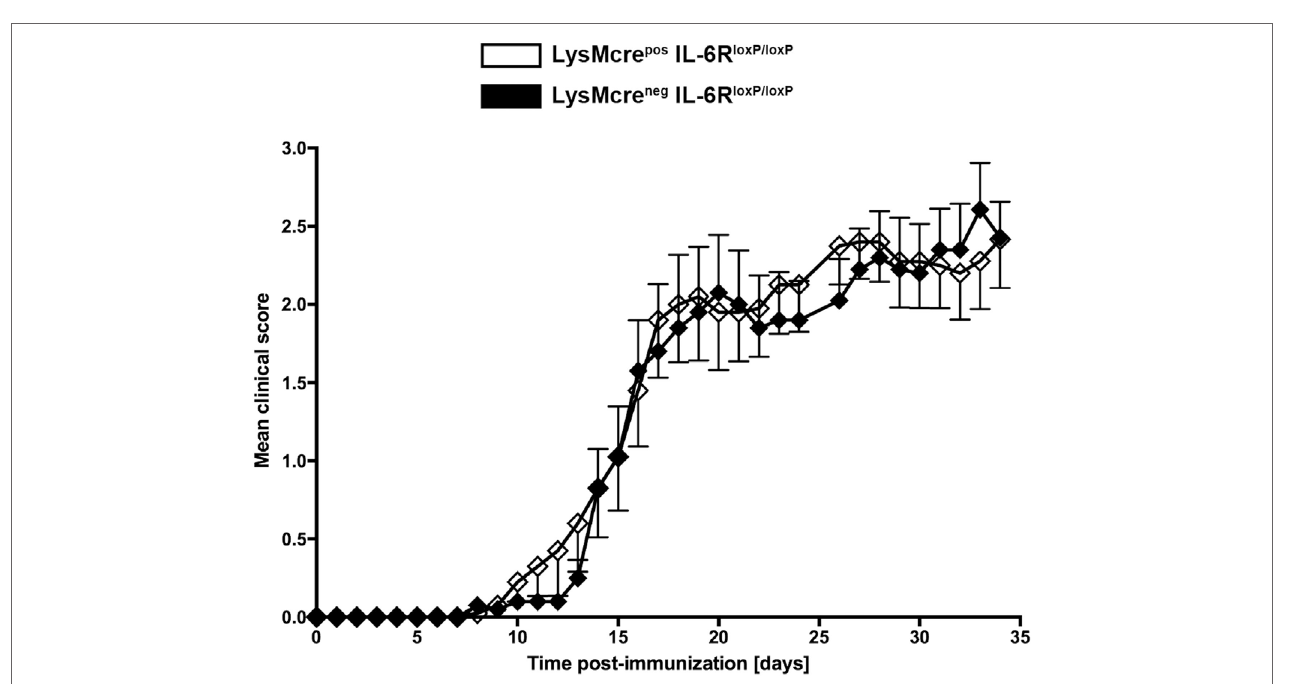
FigUre 4 | Disease progression in immunized LysMcre pos IL-6R loxP/loxP mice and LysMcre neg IL-6R loxP/loxP mice. LysMcre pos IL-6R loxP/loxP mice (white rhombs) and LysMcre neg IL-6R loxP/loxP littermates (black rhombs) were immunized with MOG 35–55 /CFA. Clinical course of EAE in LysMcre pos IL-6R loxP/loxP mice compared with LysMcre neg IL-6R loxP/loxP littermates. One experiment representative out of two performed is shown. Data represent means and SEs of 10 mice per group. Statistical analysis was performed using Mann-Whitney